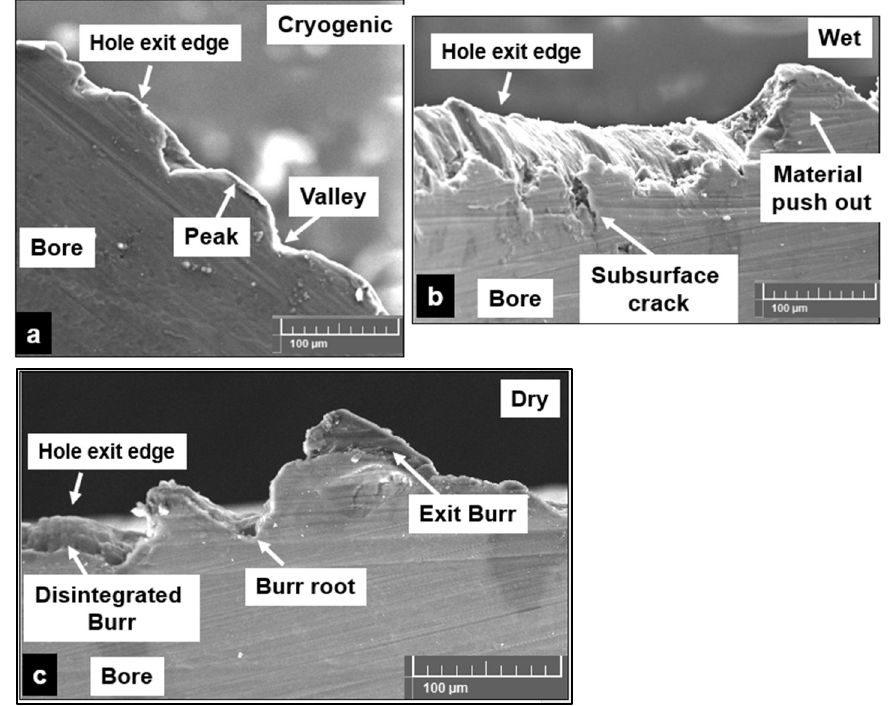
Figure 13. Different types of edges produced at the hole exit side of the Mg-9Al-1.4Zn-based hollow alumina syntactic foams: ( a ) Cryogenic. ( b ) Wet. ( c ) Dry. (Vc = 30 m/min, feed = 0.3 mm/rev, uncoated tool.).